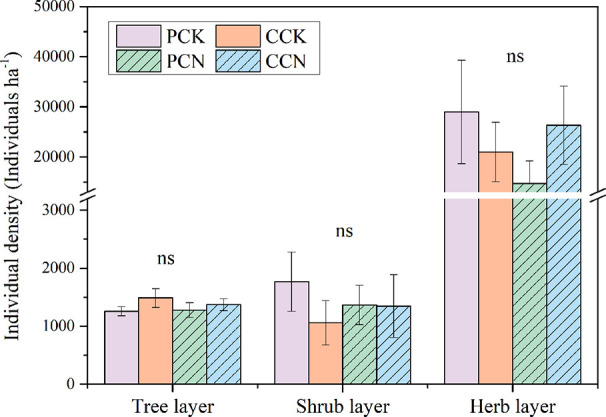
Plant individual density in the four stands. The density in the tree and shrub layer refers to the numbers of stems per ha, and that in the herb layer refers to the number of herb clusters per ha. Data are shown as means ± standard errors (n=4). Ns indicates the differences between the control and close-to-nature managed plantations were not significant according to the results of ANOVA (p > 0.05). PCK, PCN, CCK, and CCN represent the pure and close-to-nature managed P. massoniana plantation and the pure and close-to-nature managed C. lanceolata plantation, respectively.